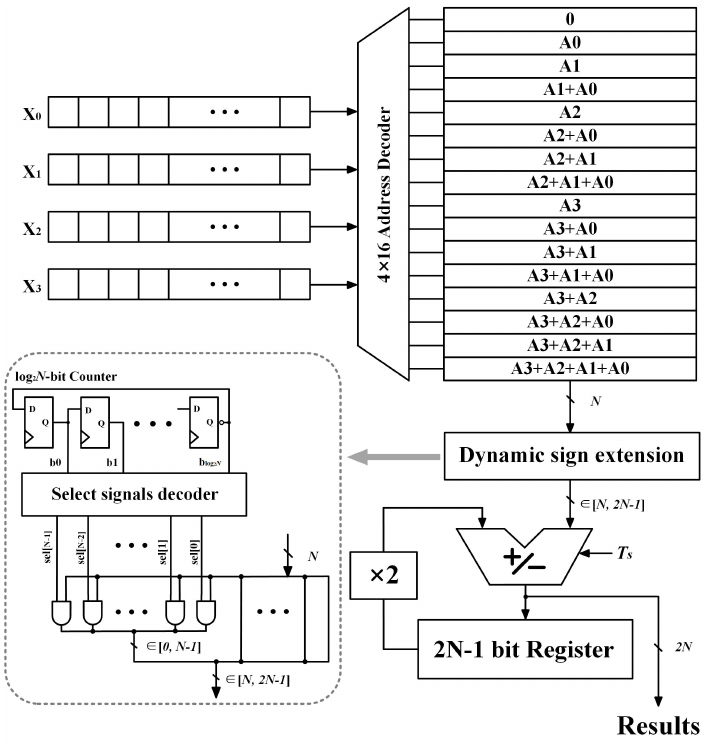
Figure 4. DA circuit with the modified dynamic sign extension block.